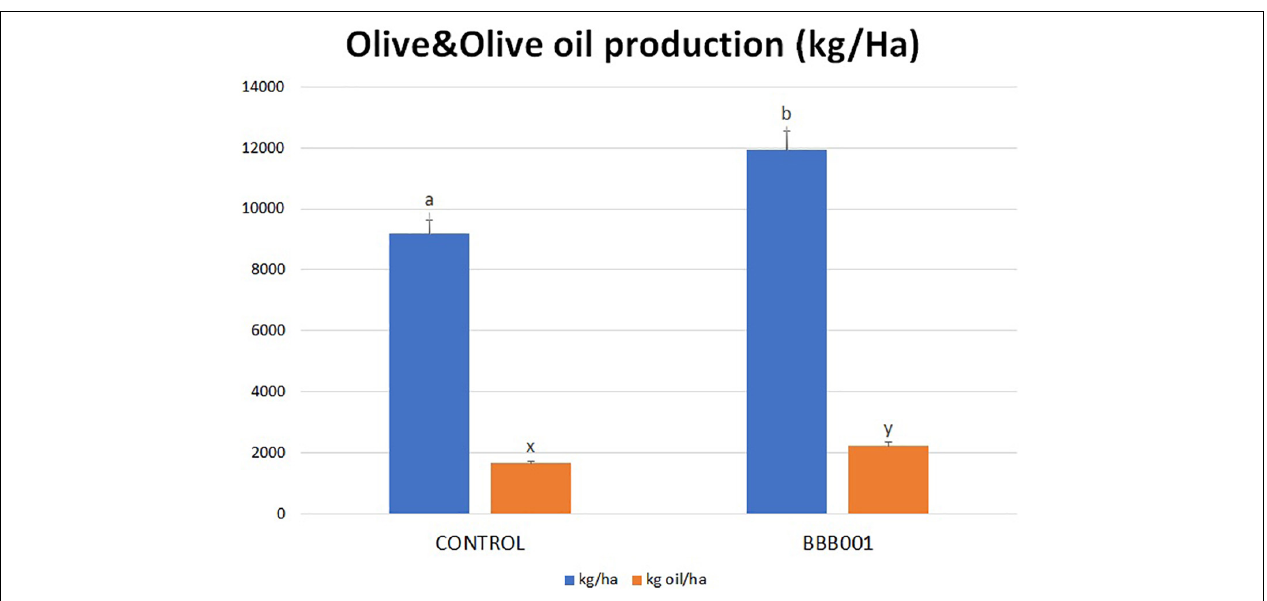
( Figure 3 ), those related to the uptake and iron metabolism were found (Coulton et al., 1983; Braun, 2003; Miethke and Marahiel, 2007) and correlate with data from phenotypic